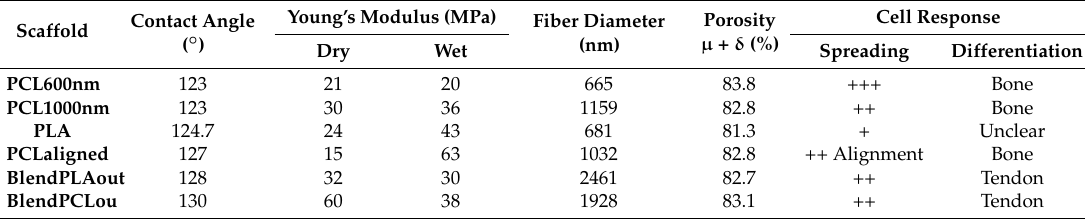
Table 2. Summary of the main results of morphological, mechanical and biological characterization of the scaffolds seeded with C3H10T1/2 stem cells. Spreading was estimated from the SEM and fluorescence acquisitions as moderate (+), high (++) or very high (+++).